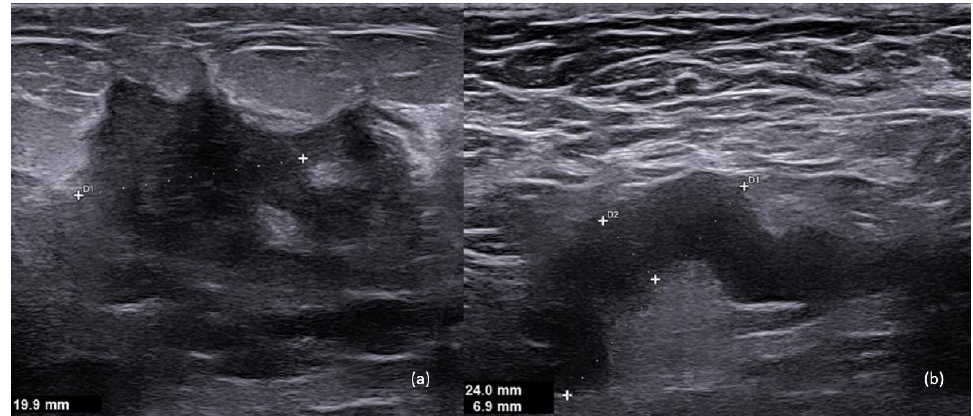
Figure 1. A 36-year-old patient, 6th week of pregnancy. ( a ) Hypoechoic mass with irregular margins in the inner lower quadrant of the left breast. ( b ) An ipsilateral axillary suspicious lymph node is seen, with cortical thickening (7 mm), which is an index of disease spread to the lymph nodes.